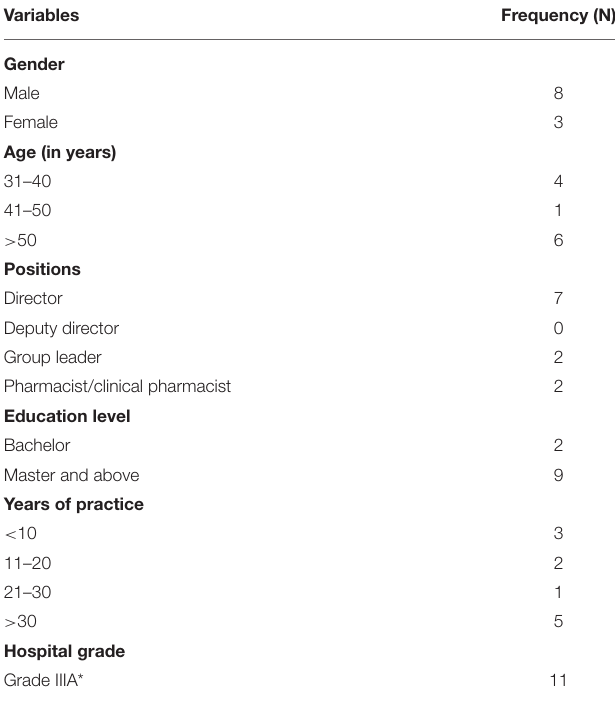
TABLE 1 | Socio-demographic characteristics of study